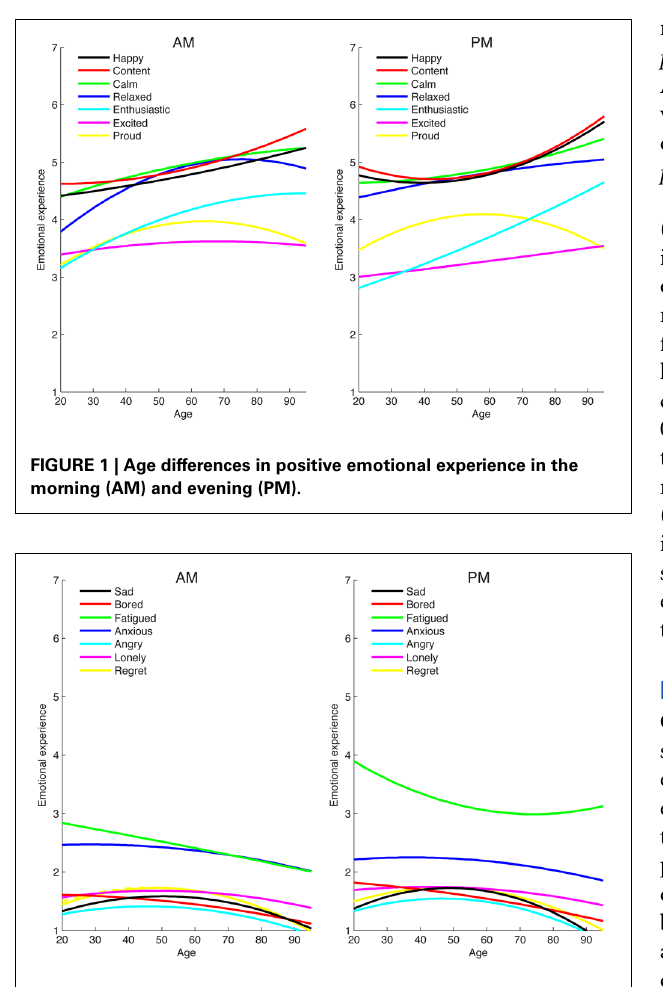
these variables might explain the effects of Age or the interaction between Age and Time of Day. The sleep variables were included together as day-level predictors; morningness was included as a person-level predictor along with its interaction with Time of